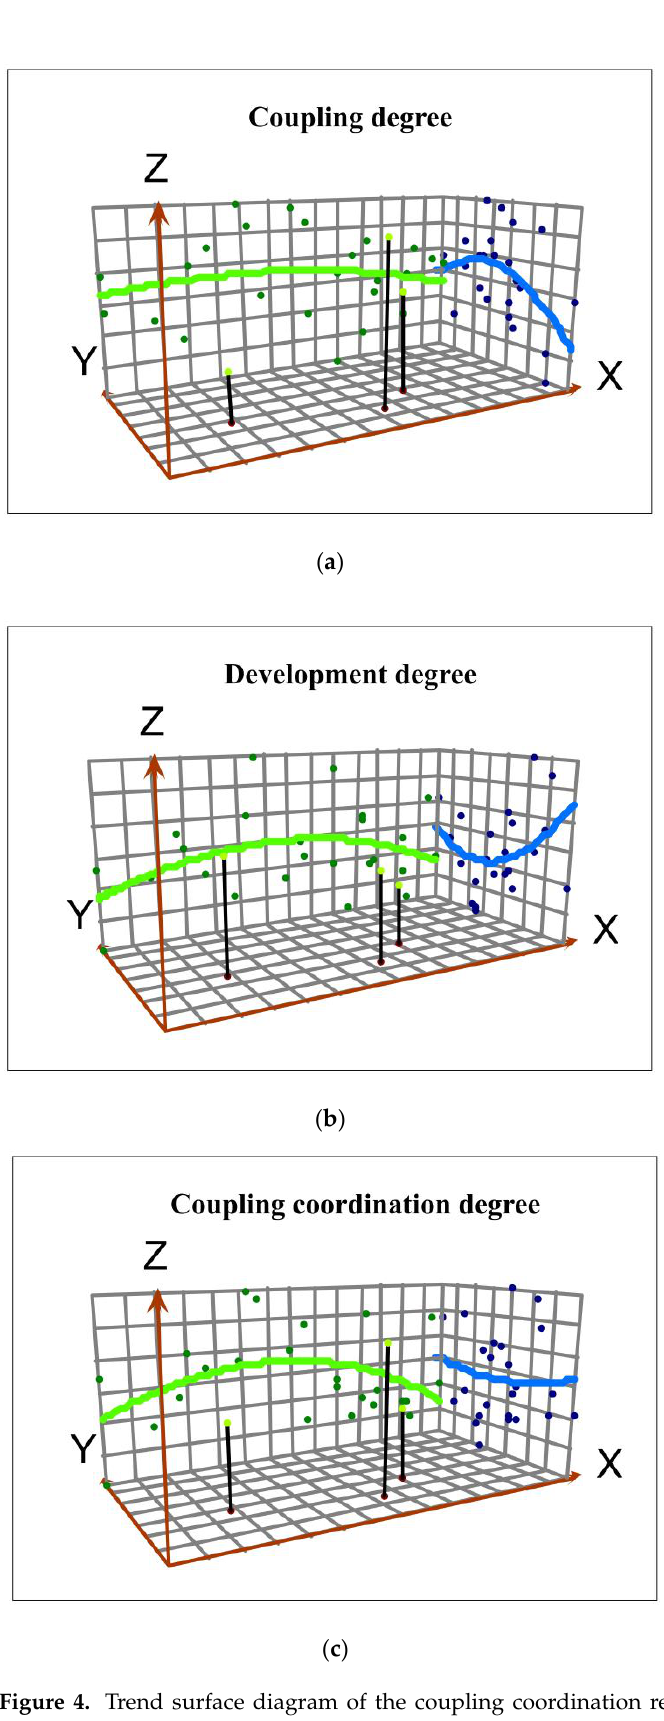
Figure 4. Trend surface diagram of the coupling coordination relationship between household live- lihood efficiency and land use in different regions (districts and counties). Coupling degree ( a ), de- velopment degree ( b ), coupling coordination degree ( c ).